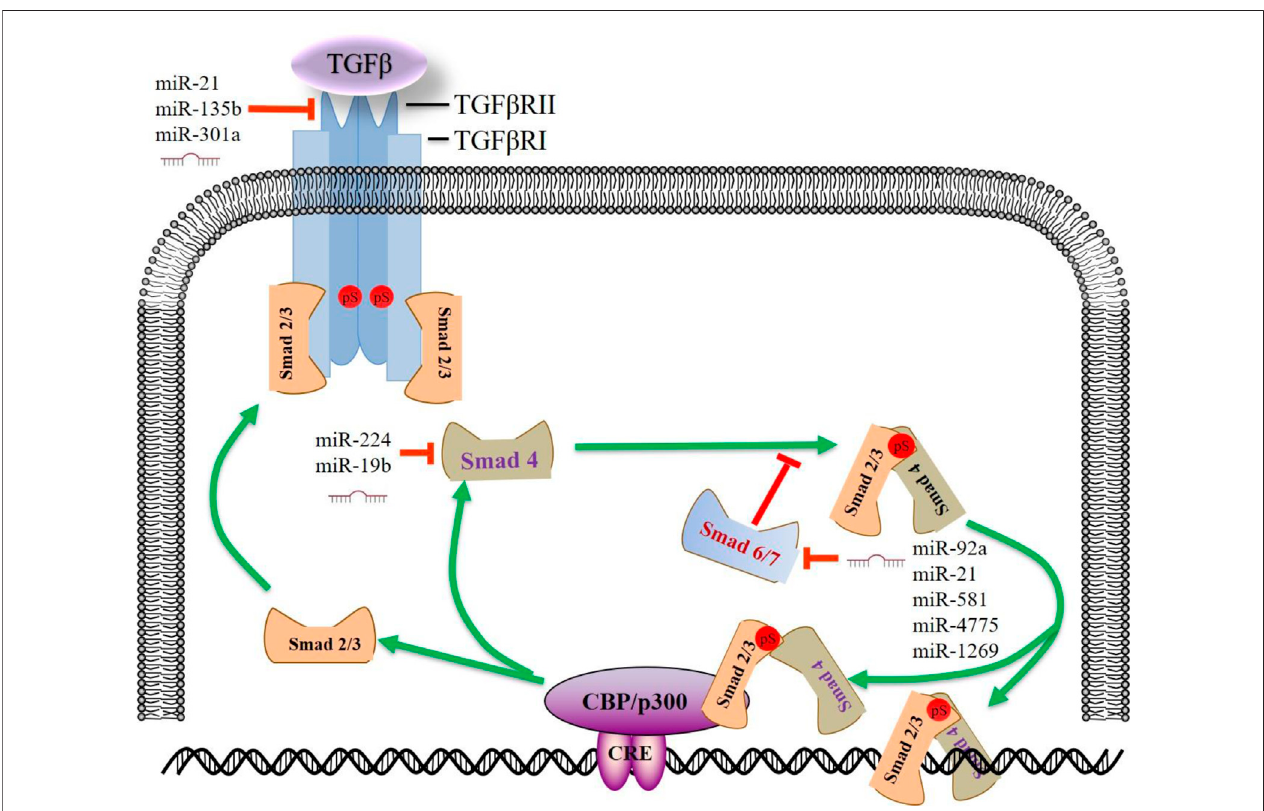
FIGURE 2 | MiRNAs regulate the TGF- β signaling pathway in CRC. Upon TGF- β stimulation, activated TGFBR2 binds to and phosphorylates TGFBR1. Activated TGFBR1 phosphorylates SMAD2/SMAD3, enabling SMAD2/SMAD3 to bind SMAD4 and subsequent activation or repression of TGF- β responsive genes. Some miRNAs enhance the TGF- β signaling by targeting SMAD7, forming a positive feedback loop. This fi gure summarizes some prominent miRNAs implicated in CRC progression by targeting TGF- β signaling pathway. miR, microRNA; CRE, cAMP response element; TGF β , transforming growth factor β ; SMAD, SMAD Family Member; TGF β R, transforming growth factor β